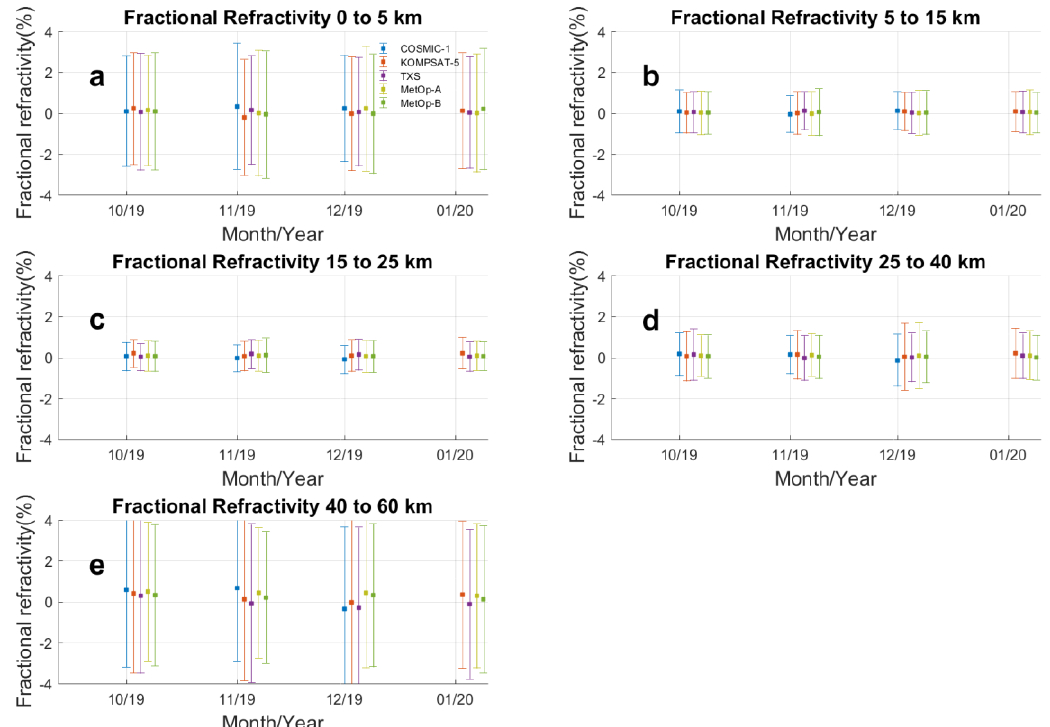
Figure 7. Monthly plots for fractional refractivity differences between COSMIC-2 and other RO missions ( a ) from the surface to 5 km altitude, ( b ) from 5 km to 15 km altitude, ( c ) from 15 km to 25 km altitude, ( d ) from 25 km to 40 km altitude, and ( e ) from 40 km to 60 km altitude from October 2019 to January